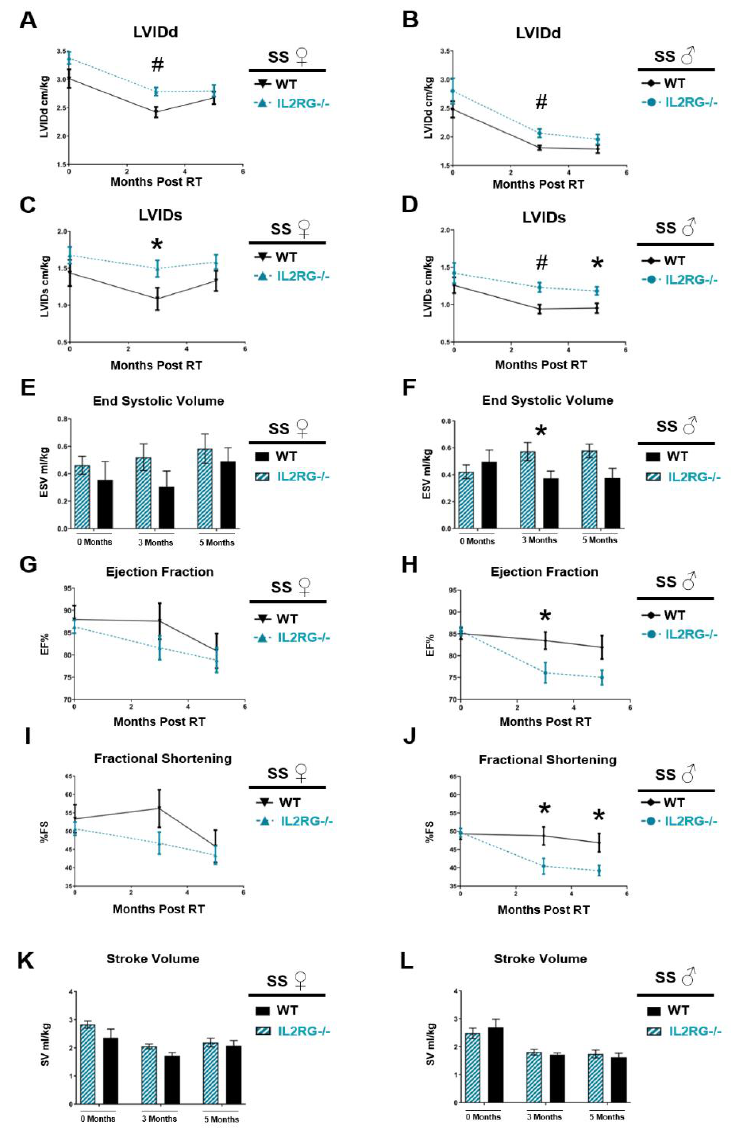
Figure 5. Immune-compromised SS IL2RG −/− male and female rats receiving localized high-dose cardiac RT have echocardiogram parameters revealing worse heart function compared to SS WT rats. SS WT and IL2RG −/− rats were given 24 Gy × 1 localized cardiac RT and echocardiograms were performed, which revealed that the left-ventricular internal diameter at end-diastole (LVIDd) ( A : female; B : male) and at end-systole (LVIDs) ( C : female; D : male) were significantly increased at three months post-RT in SS IL2RG −/− versus SS WT rats, indicating worse function. In male rats, the significantly elevated LVIDs persisted at five months. End-systolic volume (ESV) was not significantly different in female rats, ( E ) but ESV was significantly elevated at three months post-RT in male IL2RG −/− versus WT rats ( F ), which can be associated with worse cardiac function. In females, poorer ejection fraction (EF) ( G ) and fractional shortening (FS) ( I ) values were seen in the IL2RG −/− versus WT rats post-RT (not statistically significant). In males, EF ( H ) and FS ( J ) were significantly decreased in IL2RG −/− rats at three months post-RT, and FS remained decreased at five months, indicating poorer function. Stroke volume (SV) was not significantly di ff erent in ( K ) female or ( L ) male rats at any time point. Values are means ± SEM; n = 9–15 rats / group, * p < 0.05, # p <